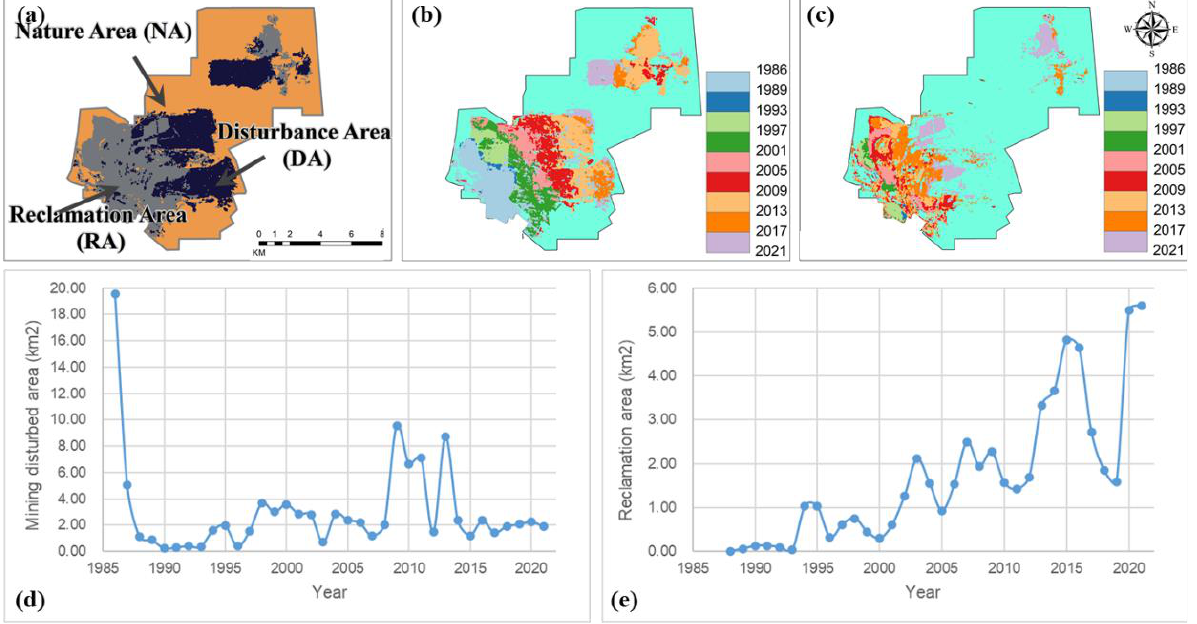
Figure 4. Year distribution map of disturbance and reclamation in Pingshuo coalfield. ( a ) The study region is divided into natural area (NA), disturbance area (DA), and reclamation area (RA); ( b ) temporal and spatial distribution of mining process; ( c ) temporal and spatial distribution of reclamation process; ( d , e ) the area of land exploited or reclaimed in each year.